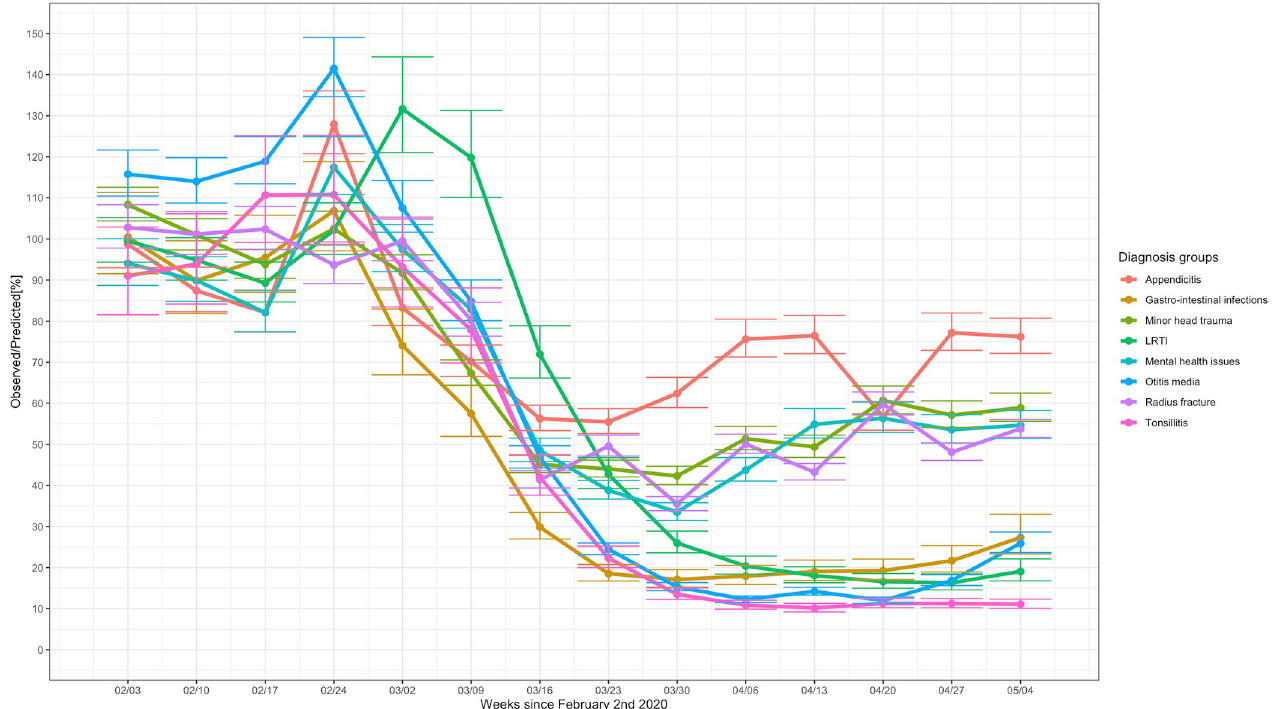
Fig 6. Observed versus predicted number of selected diagnoses (%). The observed versus predicted numbers of 8 selected diagnoses for all sites combined, for the period following February 2, 2020 until May 4, 2020. The error bars indicate the 80% prediction intervals.